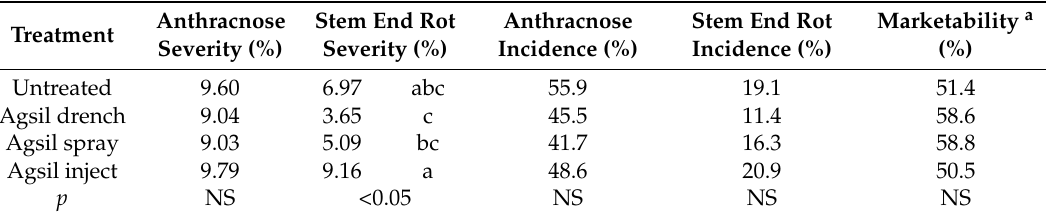
Table 4. Postharvest quality data collected from fruit harvested in August 2015 from Agsil amendment trial—Site 3, Beechmont.